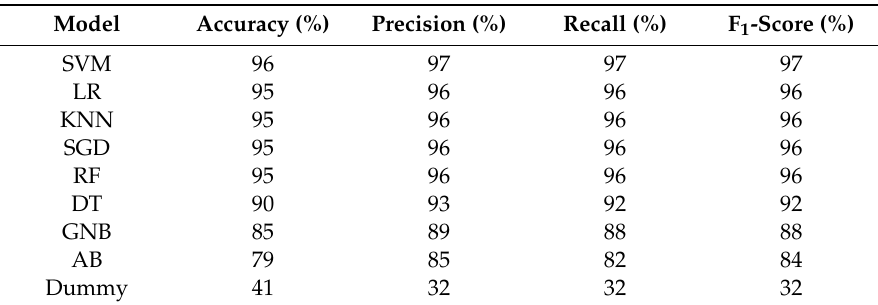
Table 4. Models performance before